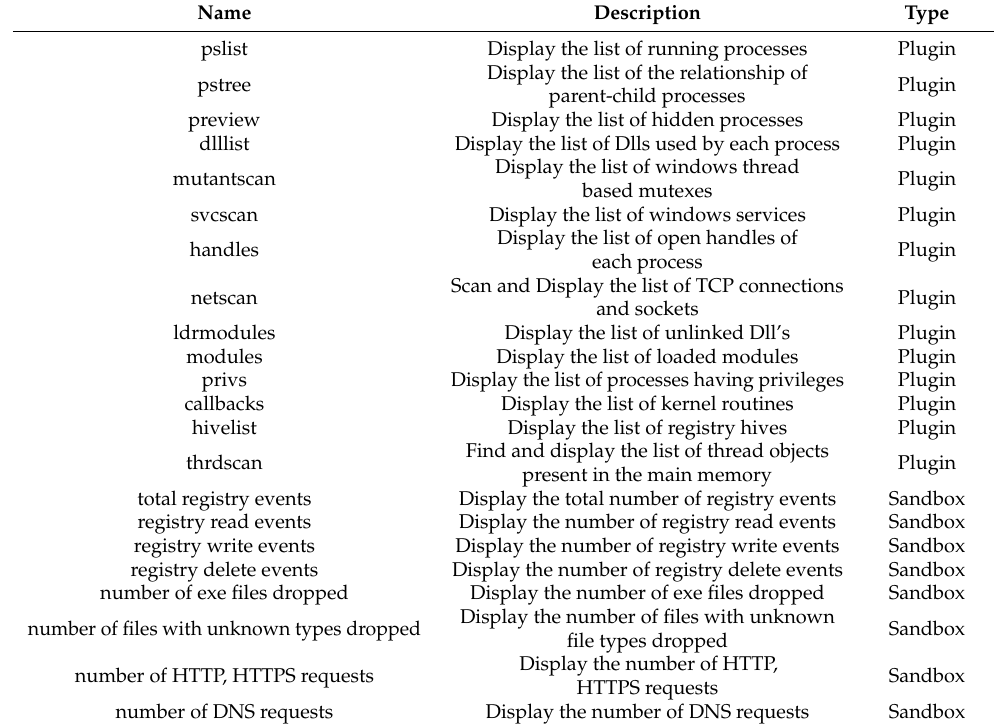
Table 4. List of Volatility plugins used to extract features from memory dumps and the features extracted from the online sandbox.